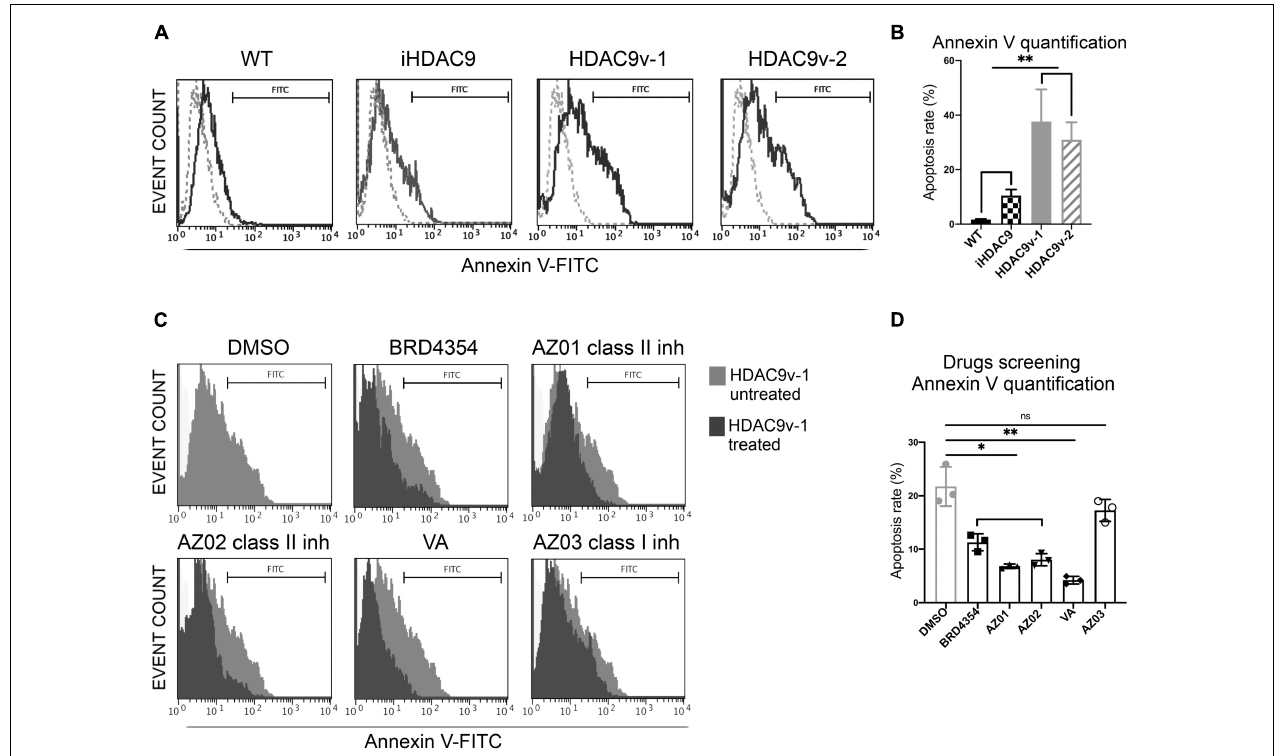
FIGURE 3 | Smooth muscle cells with the stroke risk variant show higher level of apoptosis and respond to HDAC inhibitors treatment. (A) Flow cytometric analysis of Annexin V (FITC) show percentage gated for in WT1 (2.9%), iHDAC9 (9.6%), HDAC9v-1 (27.64%), and HDAC9v-2 (25.74%) SMC and unstained (dotted lines) and (B) Annexin V staining quantification ( n = 3). (C) SMC flow cytometric analysis of Annexin V (FITC) show percentage gated for HDAC9v-1 untreated (DMSO; 25.92%) and upon treatment with BRD4354 (HDAC9/HDAC5 inhibitor; 7.2%) (10 µ mol/L); AstraZeneca HDAC class II inhibitors AZ01 (3.52%) and AZ02 (4.30%) (10 µ mol/L); sodium valproate [valproic acid (VA); 3%] (1 mmol/L); and HDAC class I inhibitor AZ03 (19.81%) (10 µ mol/L); and (D) Annexin V positive staining quantification ( n = 3). The results are presented as means ± SD of three independent experiments. ∗ P < 0.05; ∗∗ P < 0.01; ns, not significant. Statistical analysis was performed by 1-way ANOVA with Tukey’s multiple comparison